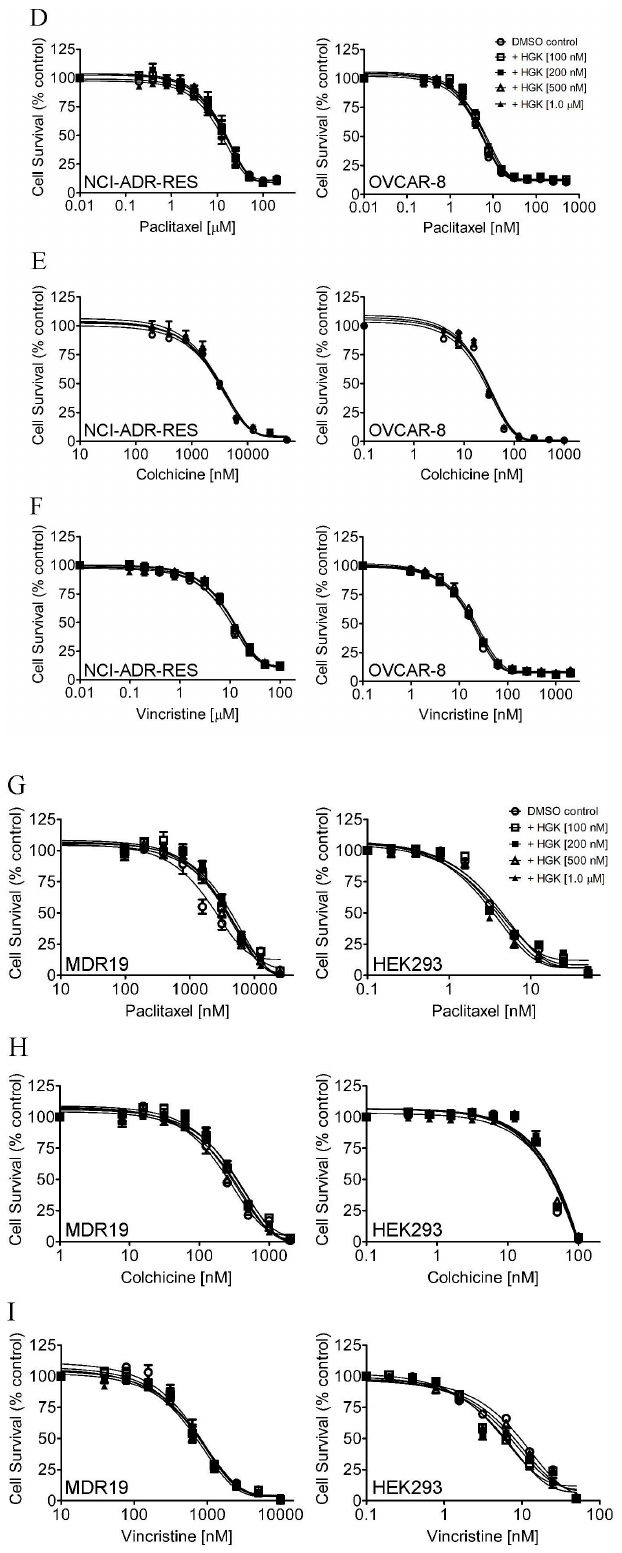
Figure 2. Cytotoxicity of ABCB1 substrate drugs in the absence or presence of hydroxygenkwanin. The cytotoxicity of paclitaxel, colchicine, and vincristine was determined in ( A – C ) KB-V1 and KB-3-1, ( D – F ) NCI-ADR-RES and OVCAR-8, and ( G – I ) MDR19-HEK293 and pcDNA3.1-HEK293 cells in the presence of DMSO (open circles) or hydroxygenkwanin (HGK) at 100 nM (open squares), 200 nM (filled squares), 500 nM (open triangles), or 1.0 µ M (filled triangles), as described in the Section 4. Points, mean values from at least three independent experiments; bars;